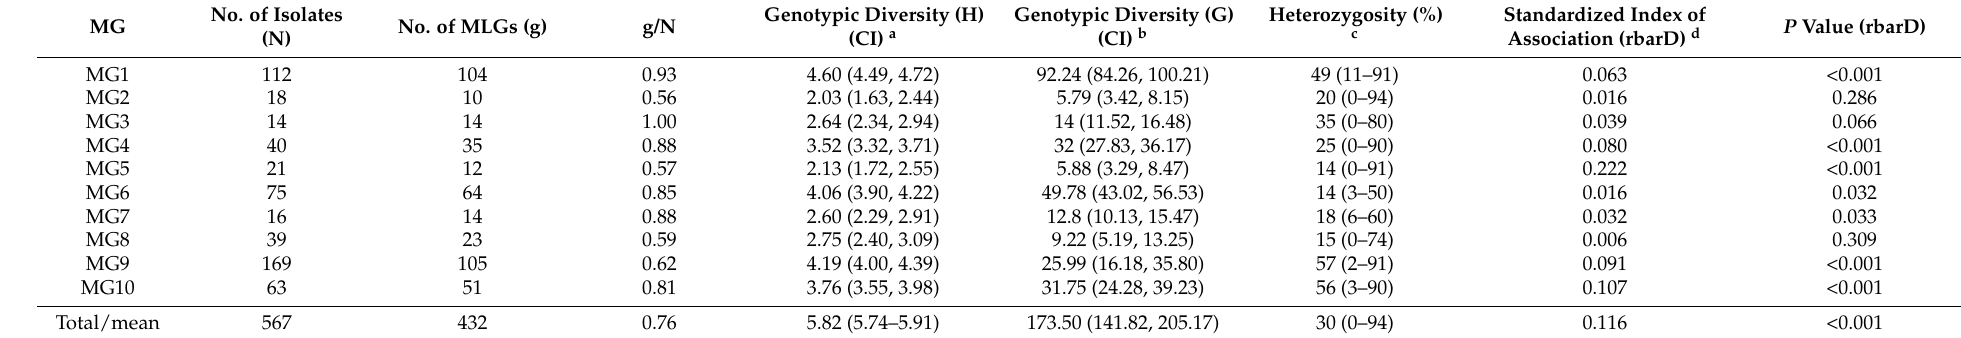
Table 2. Numbers of Puccinia striiformis f. sp. tritici isolates, numbers of multi-locus genotypes (MLGs), g/N values, heterozygosity, Stoddart and Taylor’s MLG diversity (G) and confidence interval (CI), and Shannon–Wiener index of MLG diversity (H) over 14 SSR loci, as well as standardized index of association (rbarD) and its probability ( P ) for indication of reproduction mode in ten molecular groups (MGs).